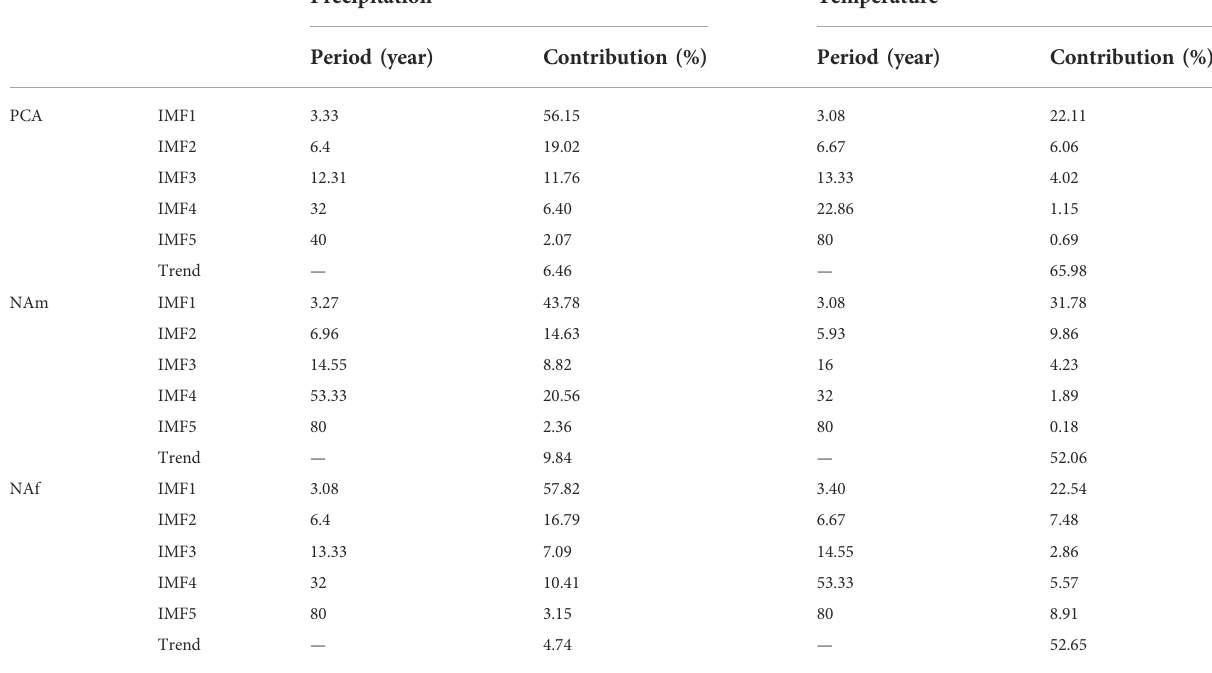
TABLE 2 Periods of the precipitation and temperature components after the EEMD and their variance contribution